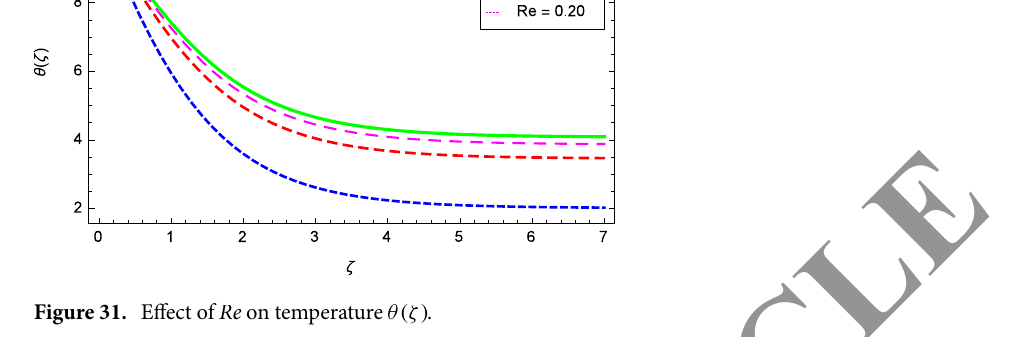
Figure 32. Effect of ws on temperature θ(ζ) .